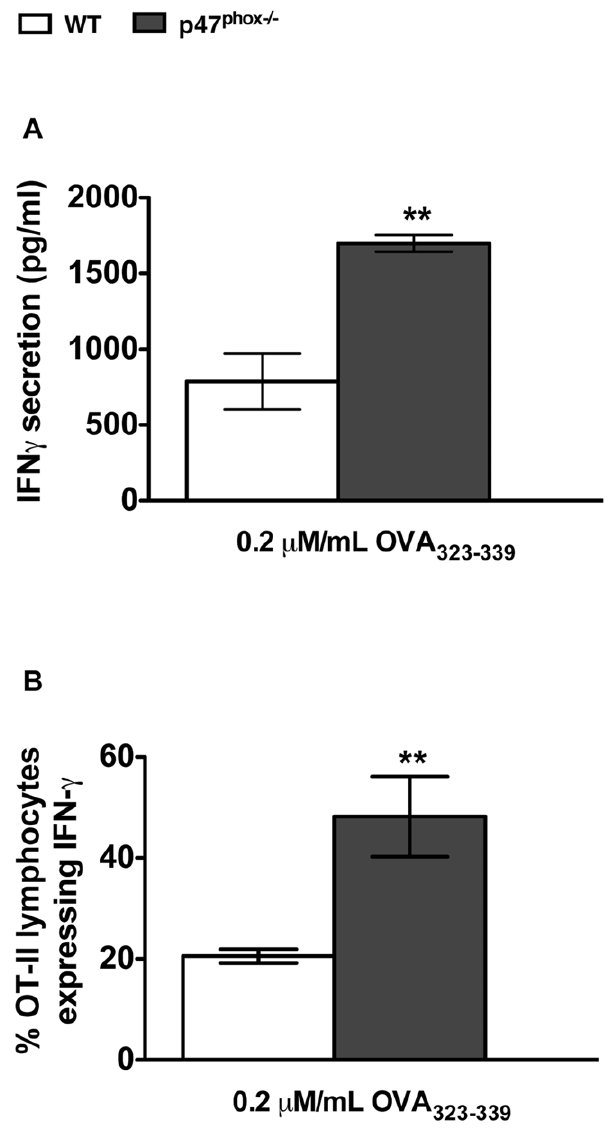
Figure 2. p47 phox 2 / 2 DC bias more OT-II T lymphocytes to secrete IFN c . OT-II lymphocytes were stimulated with mature OVA 323–